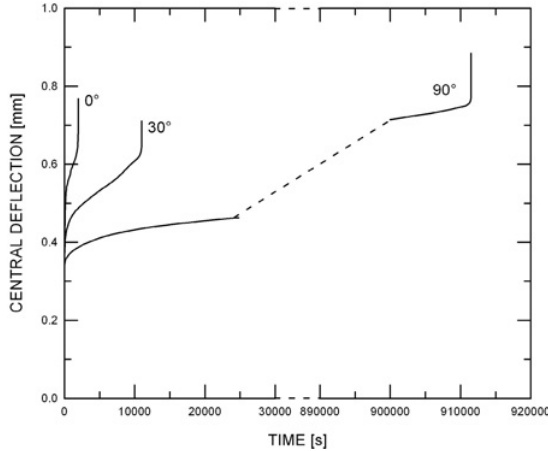
Figure 5. Example of the time dependence of measured central deflection.